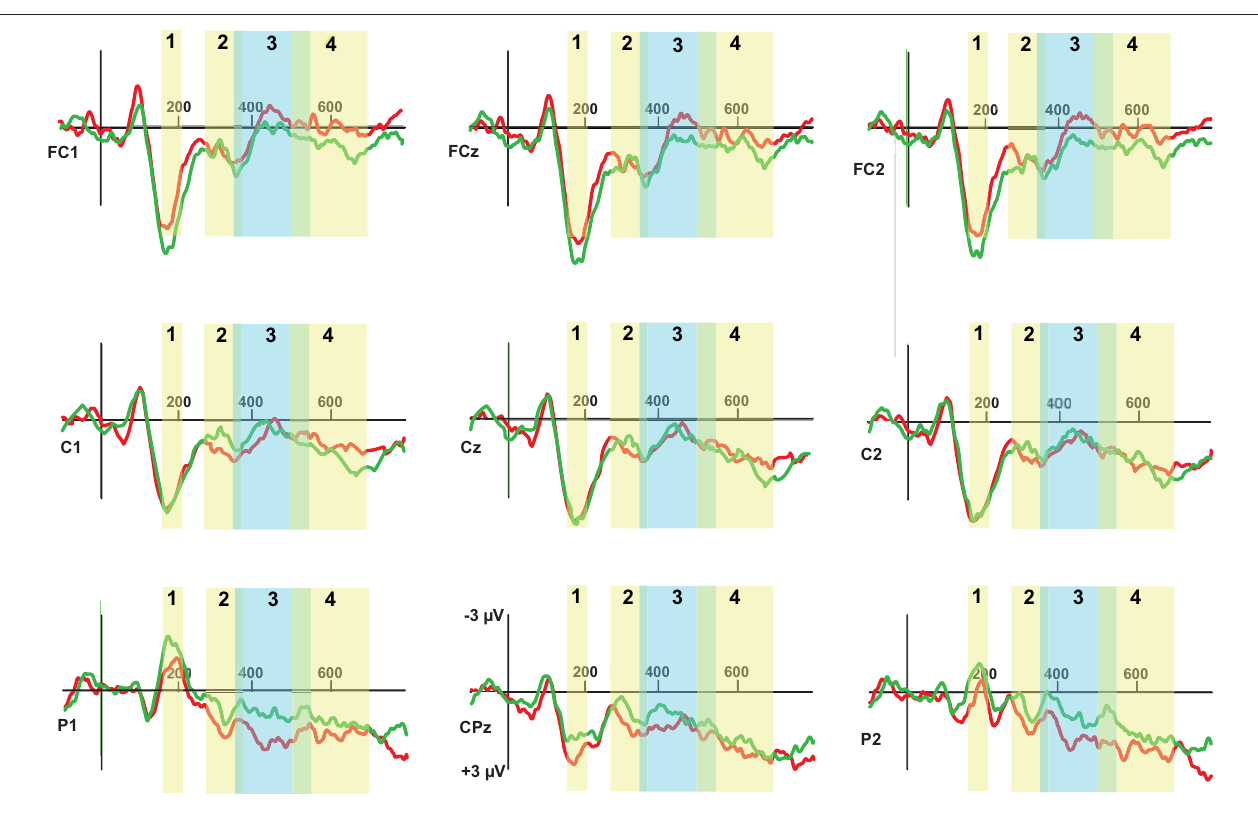
FiguRE 1 | Event related potential traces for true sentences for nine selected sites across the scalp, time locked to onset of the critical word (presented at 0 ms). Negative activation is plotted up. The red lines show the